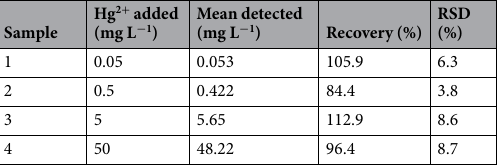
Table 1. Determination of Hg 2 + in tap water samples using the AuNZ-PAD. * Mean values and RSDs were obtained from three independent